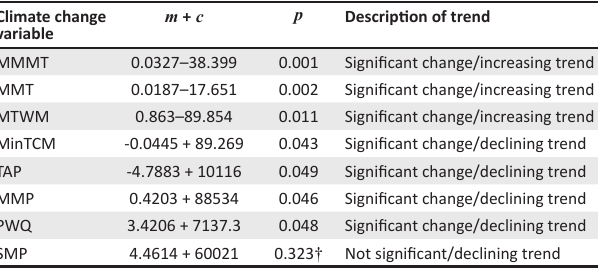
TABLE 1: Bioclimatic variables explaining climate change in Masvingo city, Zimbabwe. Climate change